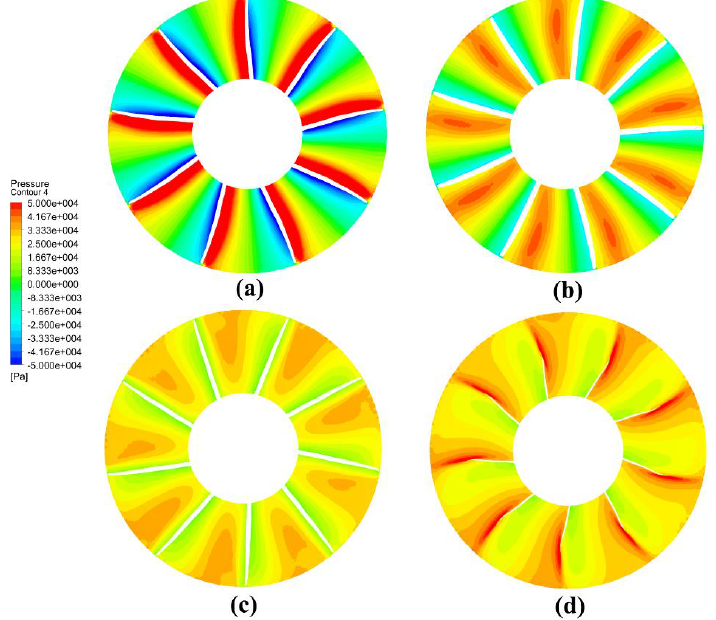
Figure 28. Axial section pressure distribution of rotor after optimization: ( a ) 20% rotor channel, ( b ) 40% rotor channel, ( c ) 70% rotor channel, and ( d ) 90% rotor channel. ( b ) 40% rotor channel, ( c ) 70% rotor channel, and ( d ) 90% rotor